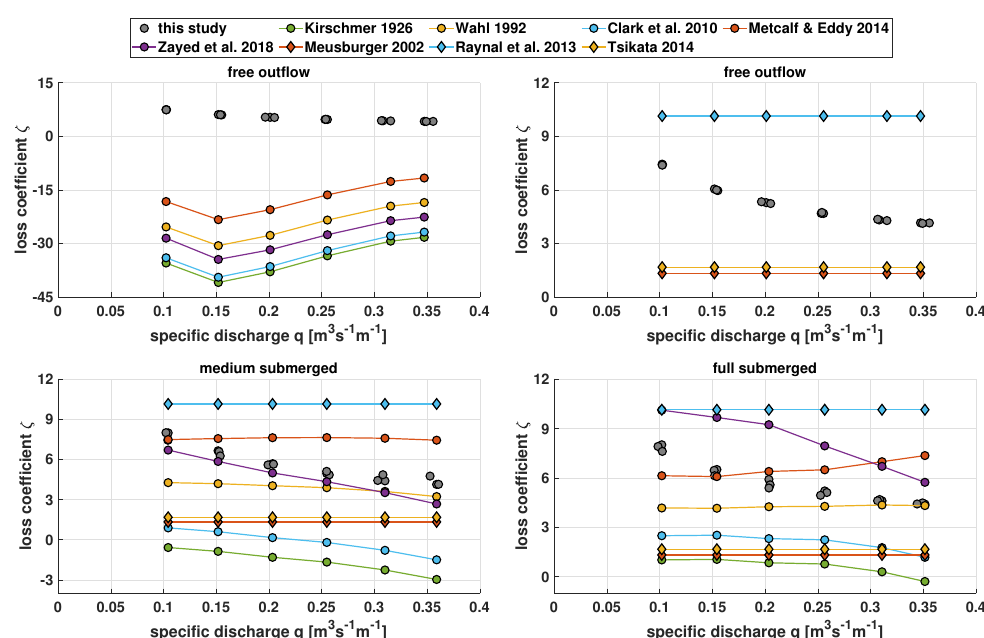
Figure 5. The determined loss coefficients from this study as a function of the discharge compared to the empirical formulas from Table1: The results are shown for the three investigated backwater conditions: ( top left ) free outflow with flow depth difference formulas, ( top right ) free outflow with hydraulic head loss formulas, ( bottom left ) medium submerged, and ( bottom right ) full submerged.